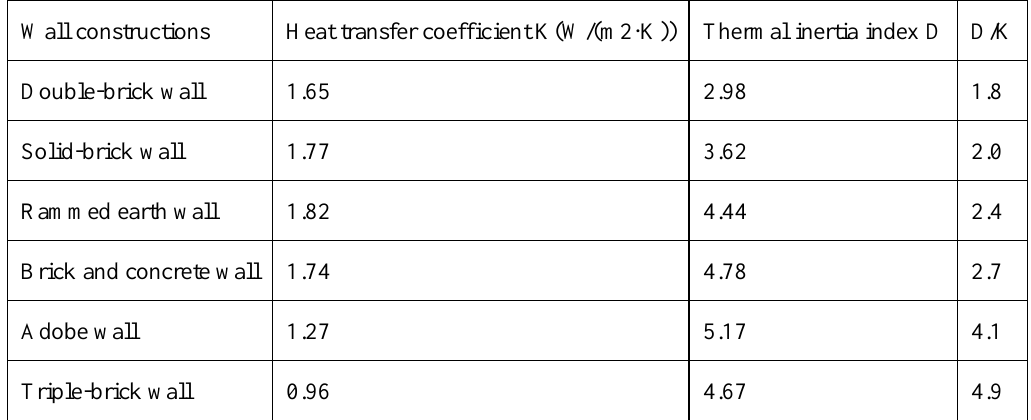
Table 11. The thermal properties of wall constructions in Xiashanhu